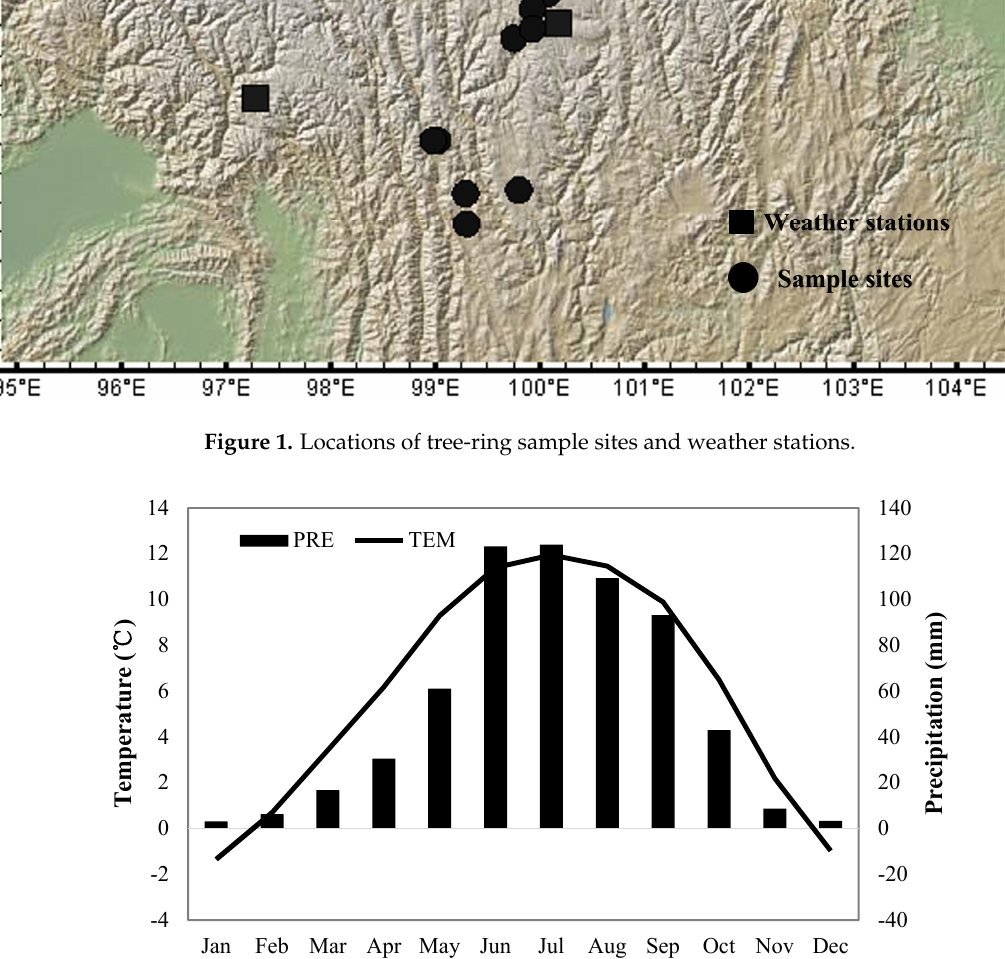
Figure 2. Regional mean monthly temperature (TEM) and precipitation (PRE) obtained with climate data from nearby meteorological stations from 1966 to 2005.